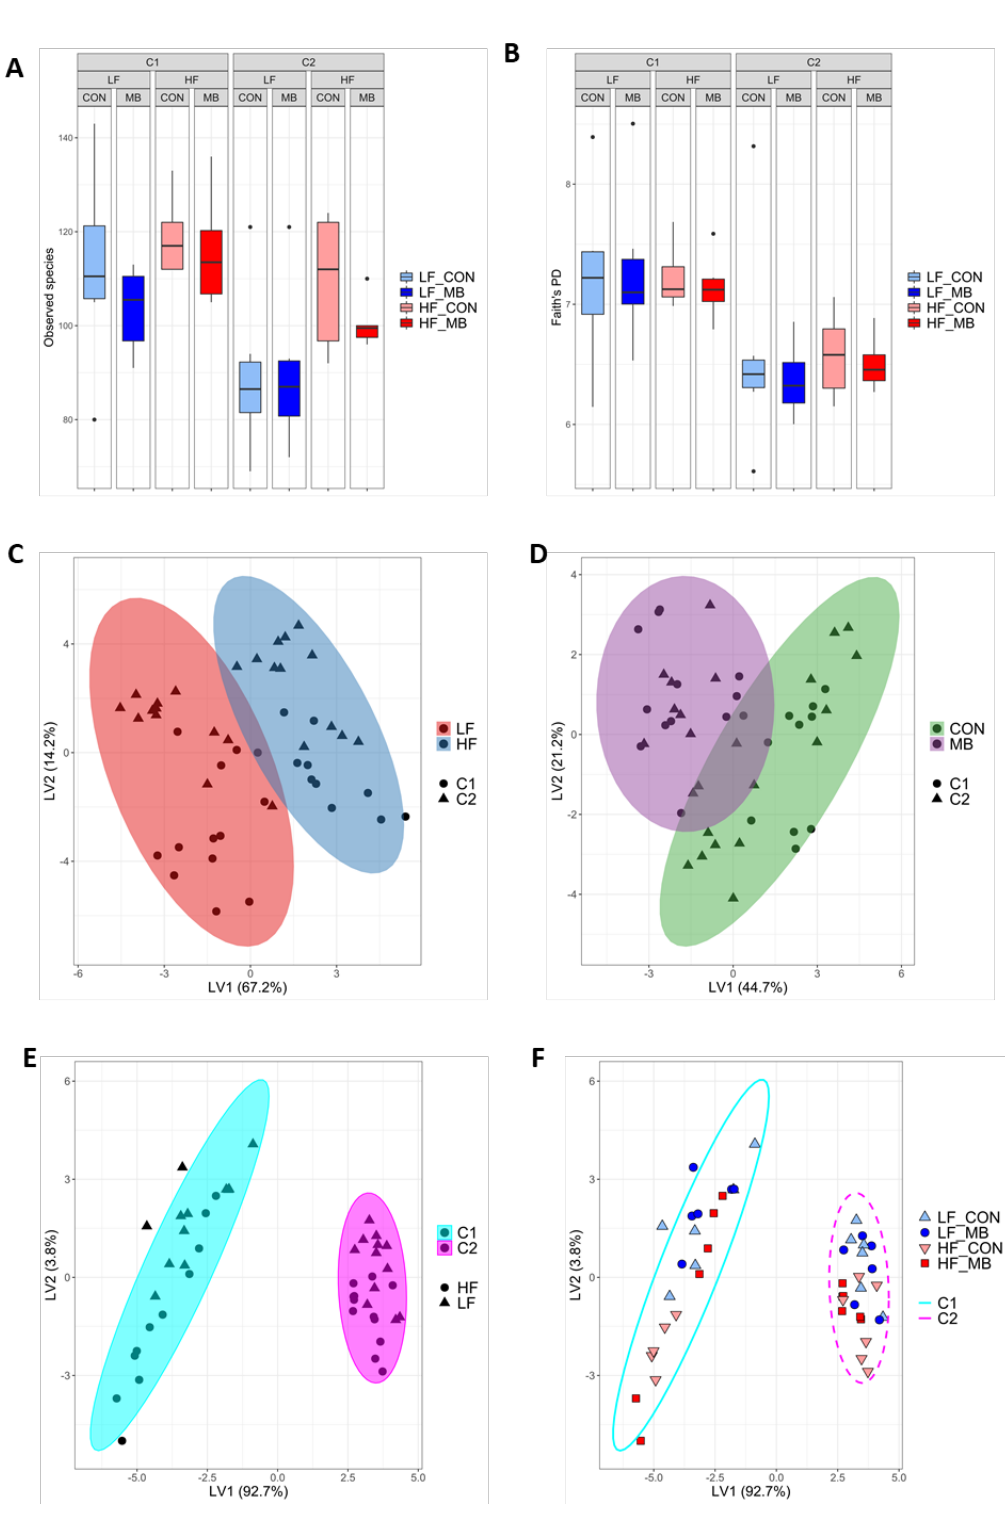
Figure 5. E ff ect of diet, MB supplementation, and cohort on fecal microbiota diversity and composition. Non-phylogenetic (observed species) ( A ) and phylogenetic (Faith’s phylogenetic diversity) ( B ) alpha diversity measures were calculated for the fecal microbiota. Partial least squares discriminant analysis (PLS-DA) scores plot of genus-level abundance data showing the separation of the variables of diet ( C ), treatment ( D ), and cohort ( E , F ). Ellipses represent 95% confidence intervals. Each symbol represents a mouse. Shape and ellipse color indicate group assignments. Latent Variable 1 and 2: LV1 and